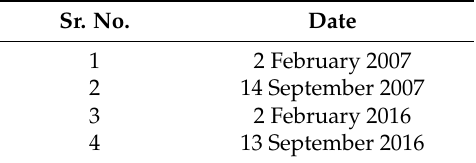
Table 1. Acquisition dates of satellite images (MODIS MOD13Q1). Sr.